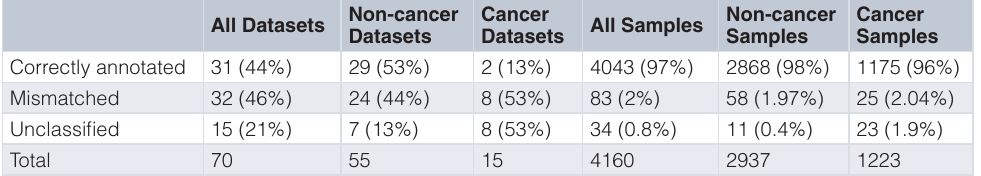
Table 1. Summary of discrepancies between the gene expression-based and annotated sex in human microarray datasets. Unclassified samples are samples with disagreement between their classification using k-means clustering and the median expression of the sex specific probesets. Datasets were considered as “correctly annotated” only if they did not contain mismatched or unclassified samples. Eight of the datasets contained both mismatched samples and unclassified